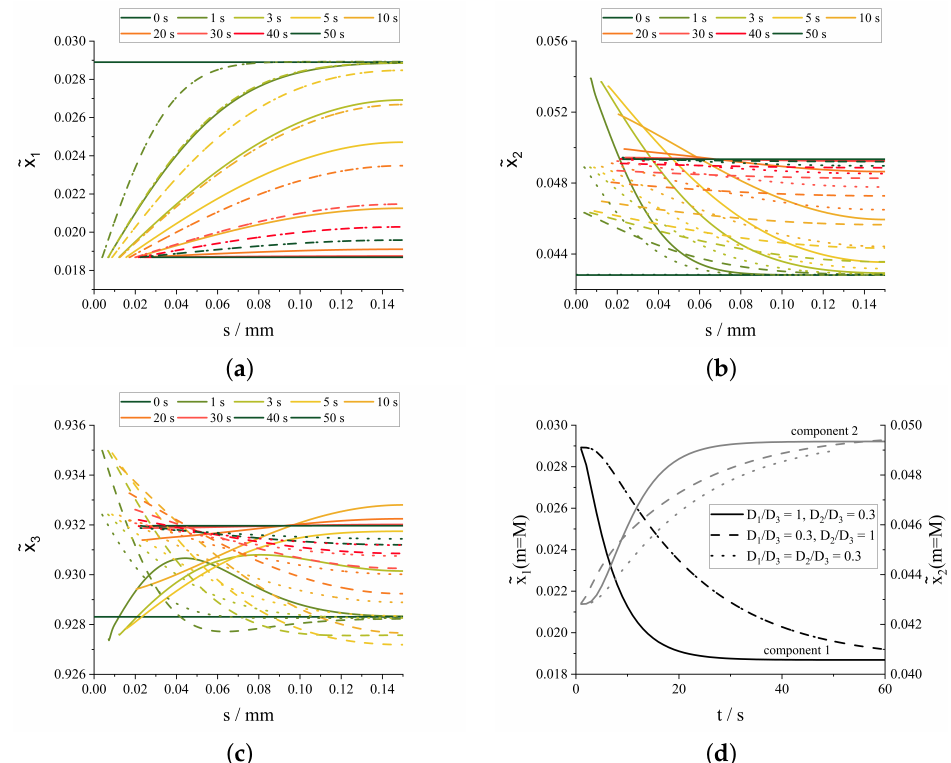
Figure 4. Simulated evolution in time and space of molar fractions of component 1 ( a ), 2 ( b ), and 3 ( c ) in solution. Diagram ( d ) shows the development of the molar fraction ˜ x i ( i = 1,2) at m = M . Full lines represent the results with self-diffusion coefficients of: D 1 / D 3 = 1 and D 2 / D 3 = 0.3. Dashed lines show the results of reduced diffusion coefficient of component 1 ( D 1 / D 3 = 0.3 and D 2 / D 3 = 1). Finally, dotted lines stand for reduced coefficients of both materials ( D 1 / D 3 = D 2 / D 3 =